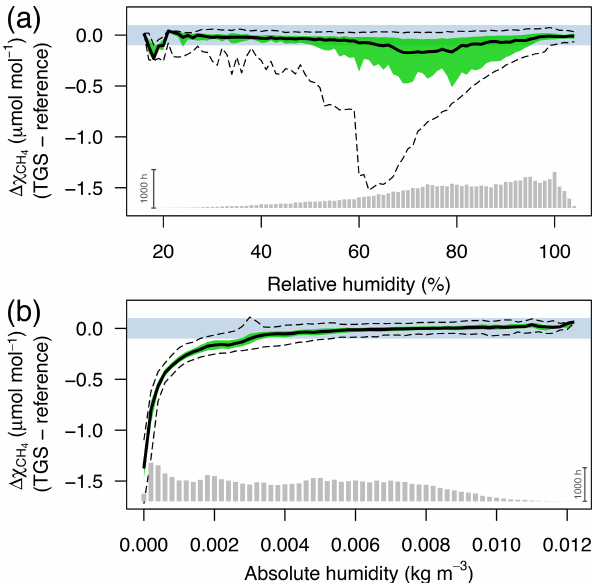
Figure 3. Difference between TGS 2600 and reference CH 4 mea- surements (30min averages) as a function of (a) relative humidity (in %) and (b) absolute humidity (in kgm − 3 ). The horizontal color bar shows the ± 0 . 1µmolmol − 1 range around a perfect agreement. The green band shows the interquartile range of bin-averaged differ- ences (TGS 2600 sensor 1), and dashed lines show the extent of the 95% confidence intervals. Gray bars at the bottom show the number of 30min averages in each bin. The scale bar (1000h) on the right specifies their